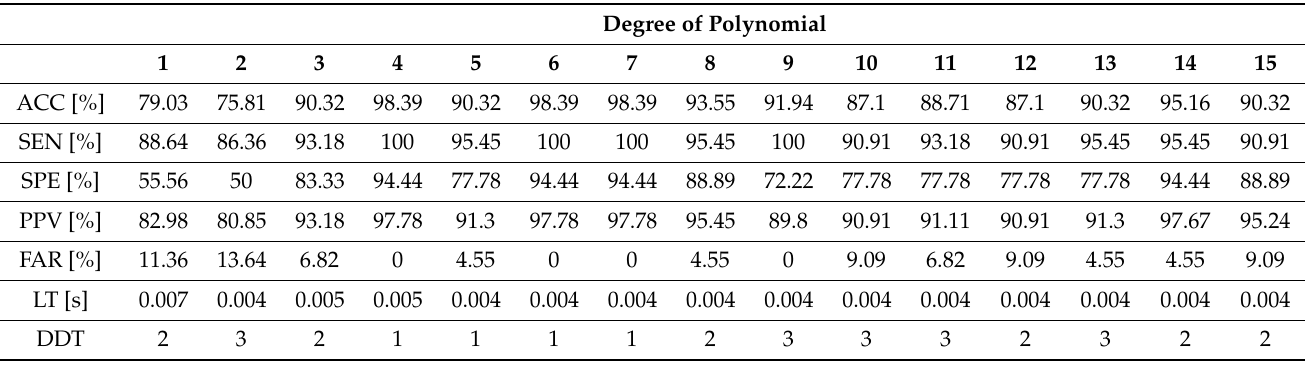
Table 1. Result of classification based on 220 samples of signal for decision tree classifier. LT—learning time, DDT—depth of decision tree.